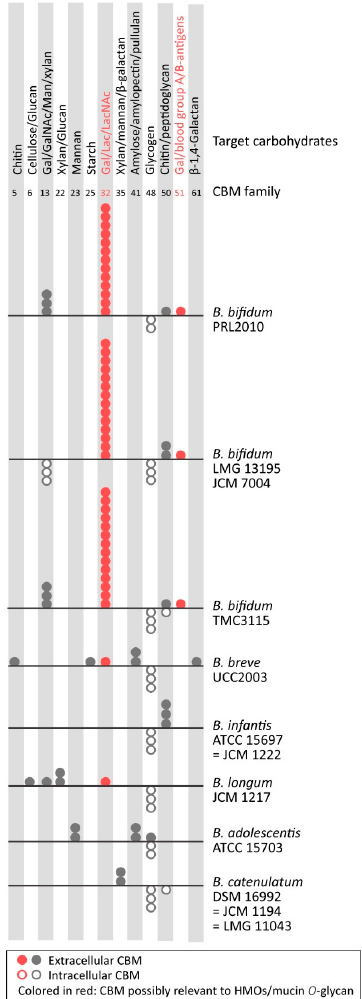
Figure 3. Distribution of carbohydrate-binding modules (CBMs) and their cellular localization in the selected Bifidobacterium species/strains. The circles represent the occurrence of CBMs (domains) classified in the CAZy database (http://www.cazy.org). The extracellular and intracellular CBMs are shown by solid and open circles, respectively. The localization of proteins including the CBMs was predicted by signalP-5.0 (http://www.cbs.dtu.dk/services/SignalP/) and TMHMM Server v. 2.0 (http://www.cbs.dtu.dk/services/TMHMM/). The pseudogenes that encode incomplete protein sequences are excluded from the analysis. The CBMs possibly associated with HMO- and mucin O - glycan degradation are colored in red.